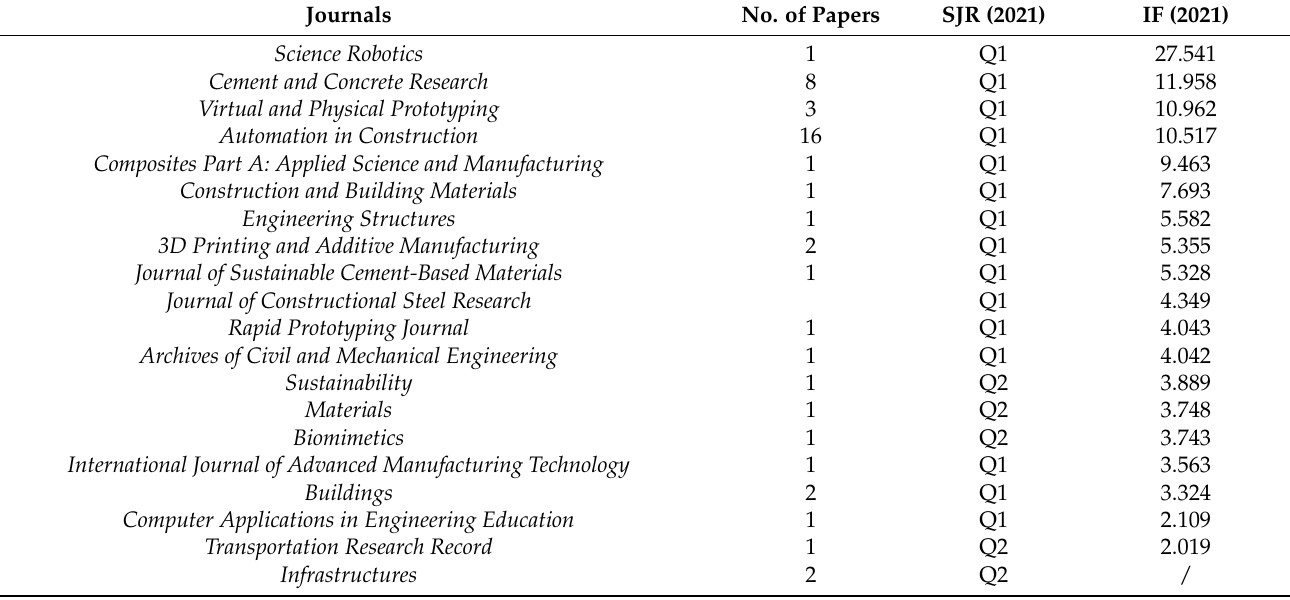
Table 2. Source journals for articles on 3DP in architecture in the analyzed literature